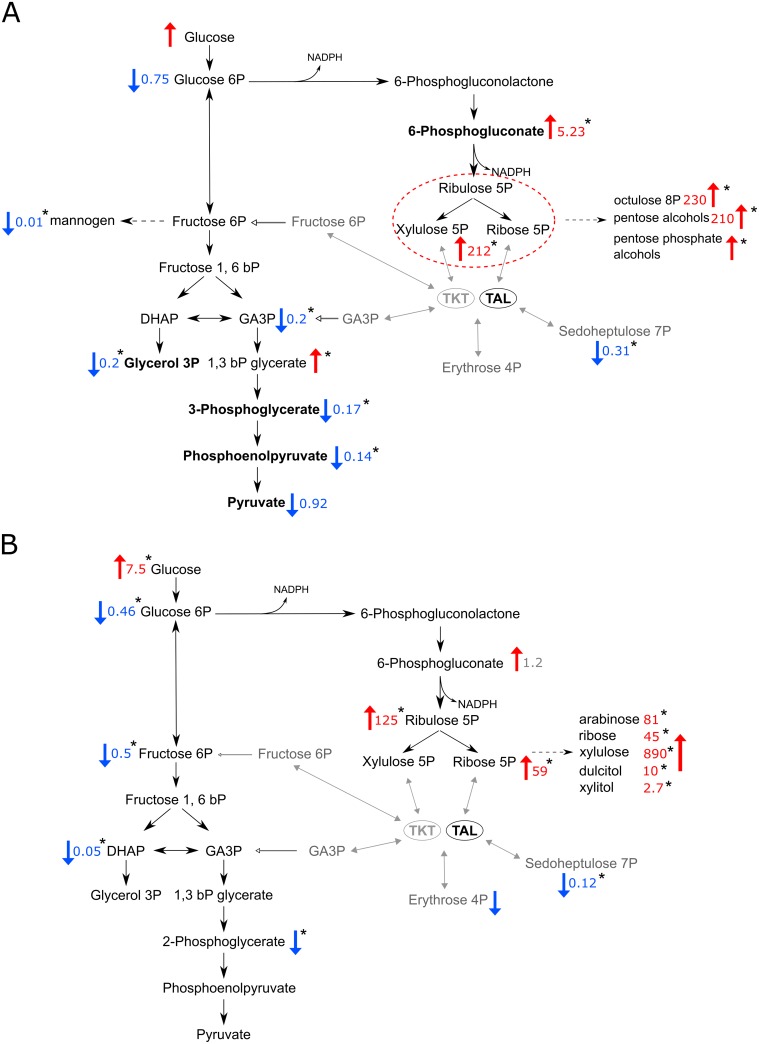
Relative changes in glycolysis and the PPP observed in metabolomic analyses.(A) Scheme of glycolysis and the PPP with indicated changes of metabolites detected by LC-MS analysis. Numbers are relative values in Δtkt compared to WT, red numbers and arrows indicate the fold increase, whereas blue indicates the fold decrease. Text and arrows in grey indicate steps missing after TKT depletion. Metabolites highlighted in bold were identified based on matches with respective standards, the rest are annotated based on mass and predicted retention time. (B) Similar scheme as in A, but showing GC-MS analysis. * p < 0.05.